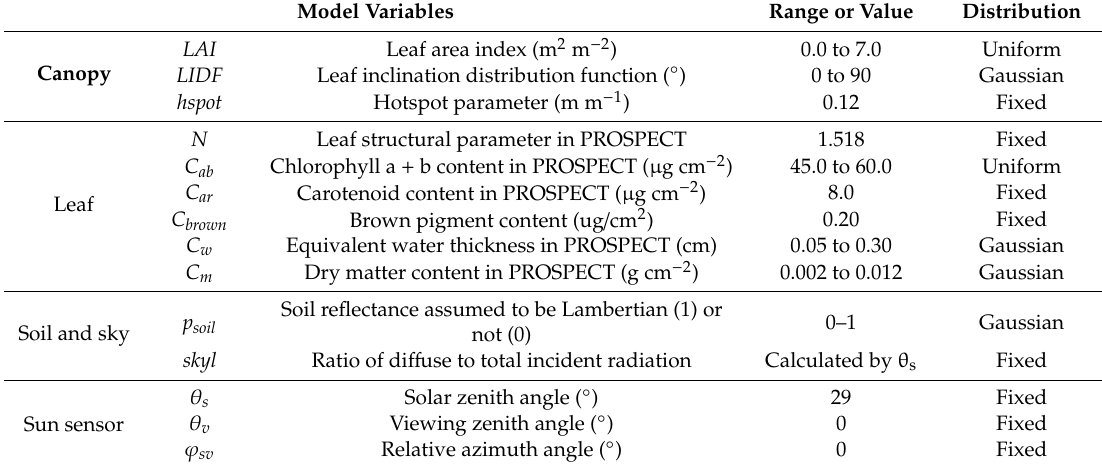
Table 2. The ranges and distributions of the PROSAIL model inputs for LAI retrieval. Model Variables Range or Value